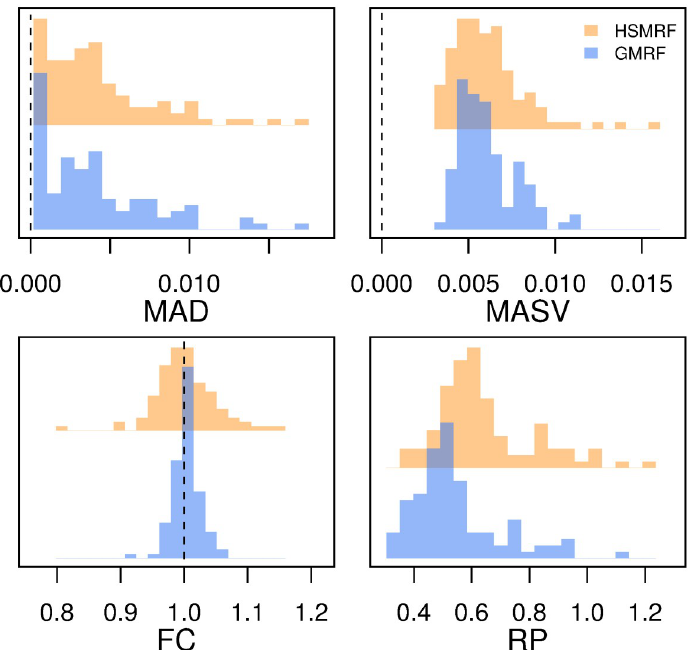
Fig 3. Performance of the models on simulated constant-rate datasets. MAD (Mean Absolute Deviation) measures the error in the estimated trajectory. MASV (Mean Absolute Sequential Variation) measures the total amount of change in the trajectory, horizontal line at true value for reference. FC (Fold Change) measures the fold change from present to past, dashed line at true value for reference. RP (Relative Precision) is a measure of precision, the average width of the 90% Credible Interval relative to the birth